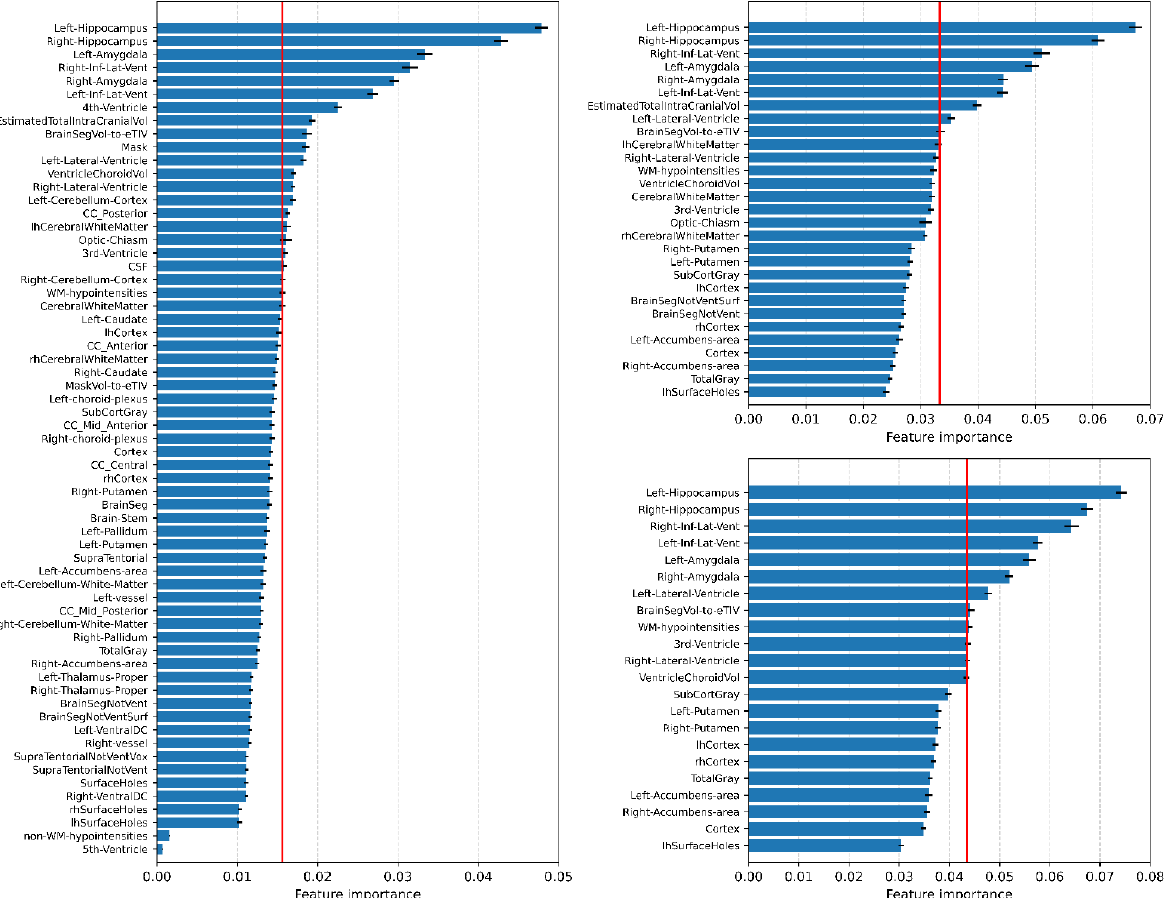
Figure 4. Feature importance obtained from RF classifier. Vertical red line is the chance level calculated. Feature importance is presented for 63, 29, and 22 feature groups.